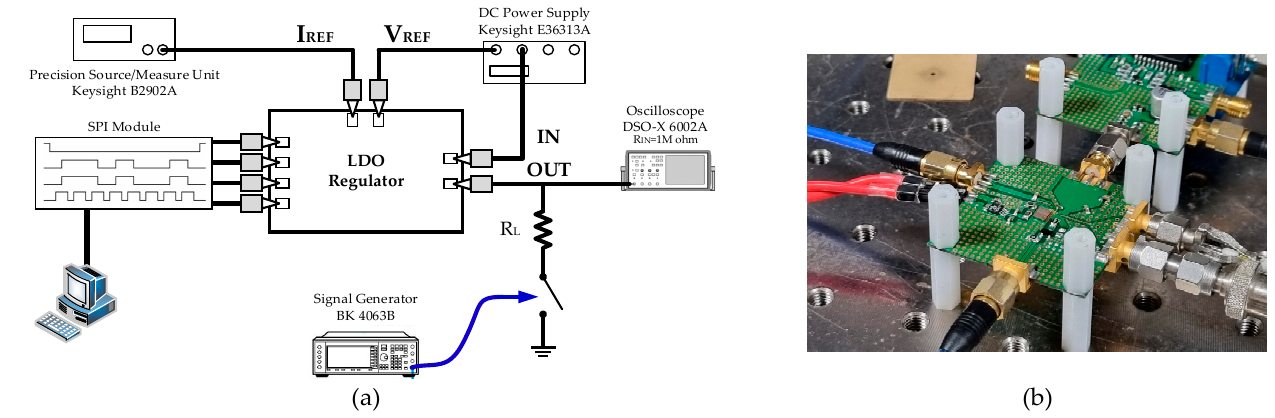
Figure 12. ( a ) Schematic diagram of the load transient measurement setting and ( b ) a photograph of the measurement setting.